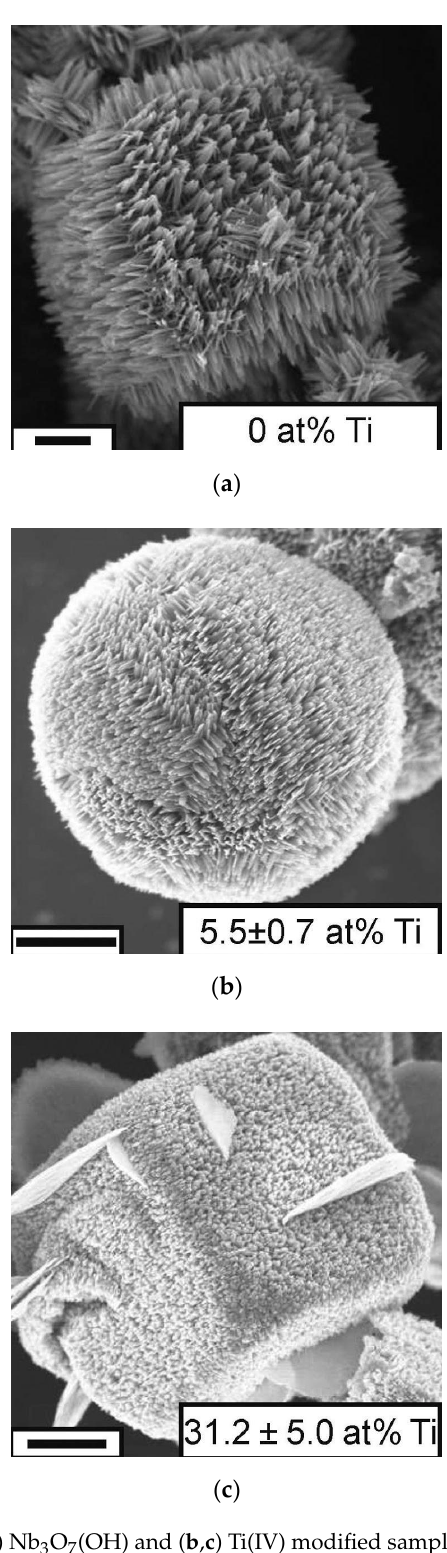
Figure 8. SEM images of ( a ) Nb 3 O 7 (OH) and ( b , c ) Ti(IV) modified samples with the titanium content averaged over the morphology indicated relative to niobium (scale bar of 1 μ m). Reprinted with permission from the authors of [51]. Copyright (2019) American Chemical Society, Washington, DC, USA.